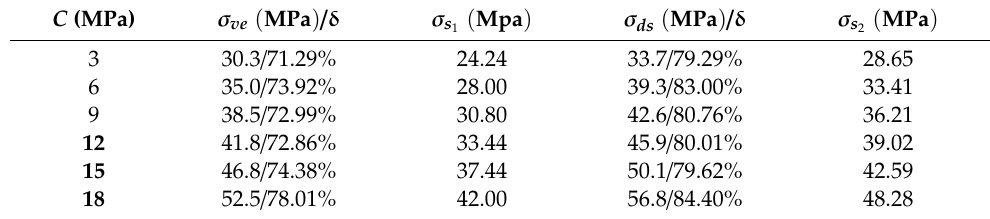
and σ s under di ff erent confining 1 2